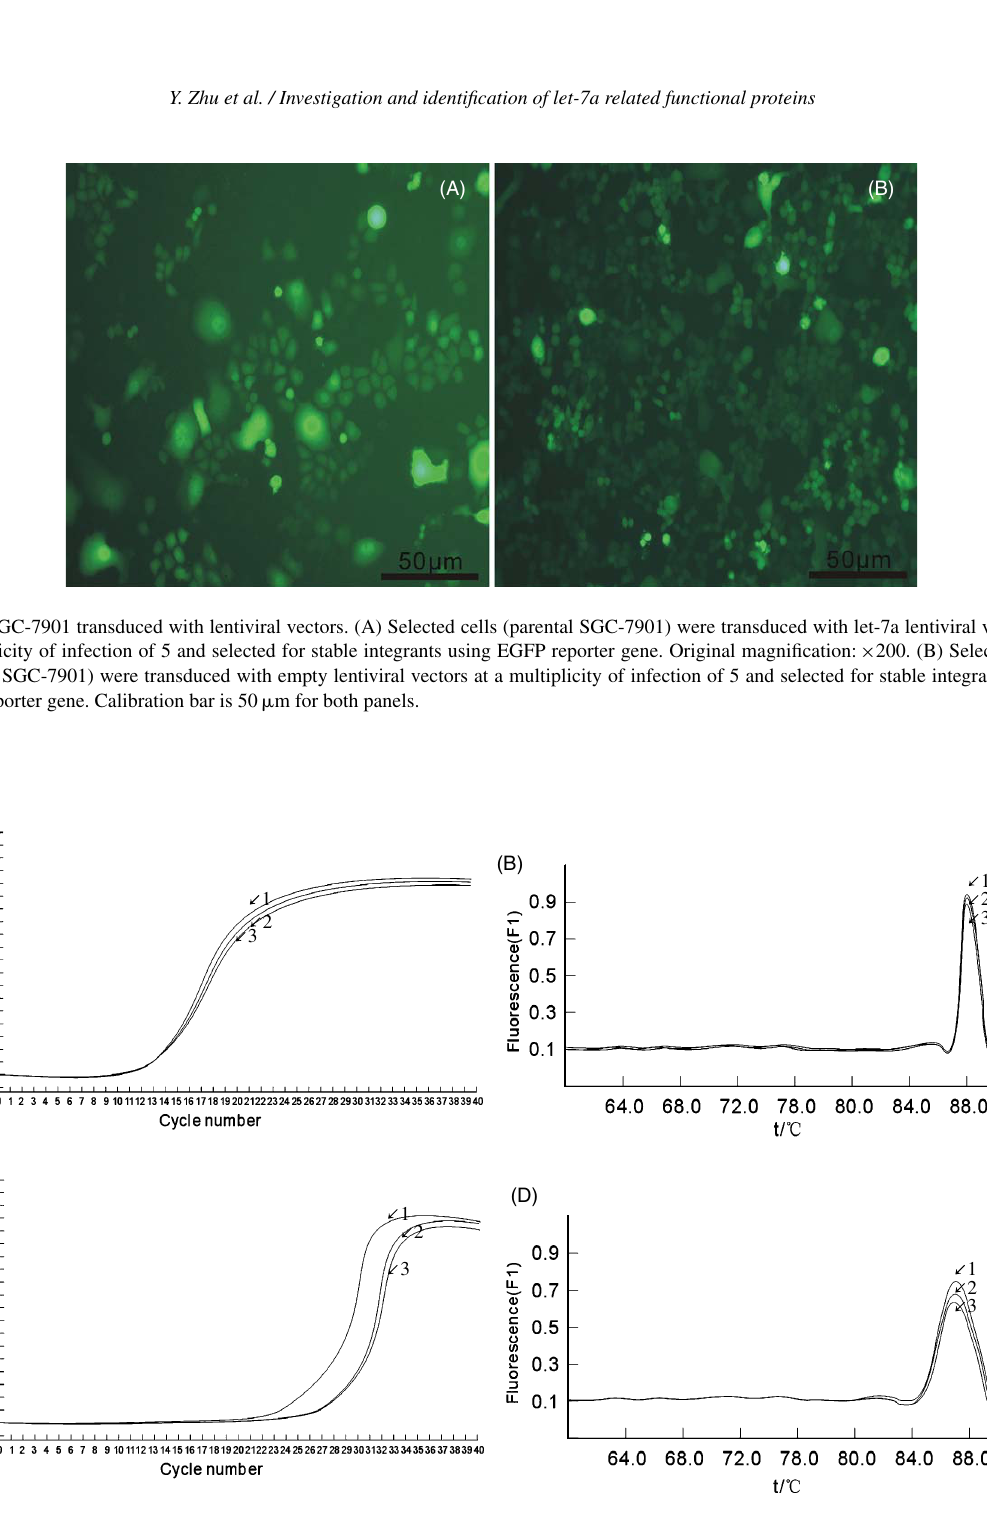
Fig.2. Representativereal-timequantitativeRT-PCRanalysisforoflet-7alevel.Theexpressionleveloflet-7awasexaminedandwasnormalized to that of 18S RNA. (A) Graph shows that 18S RNA among SGC-7901/let-7a, SGC-7901/EV and SGC-7901 cell lines has very little